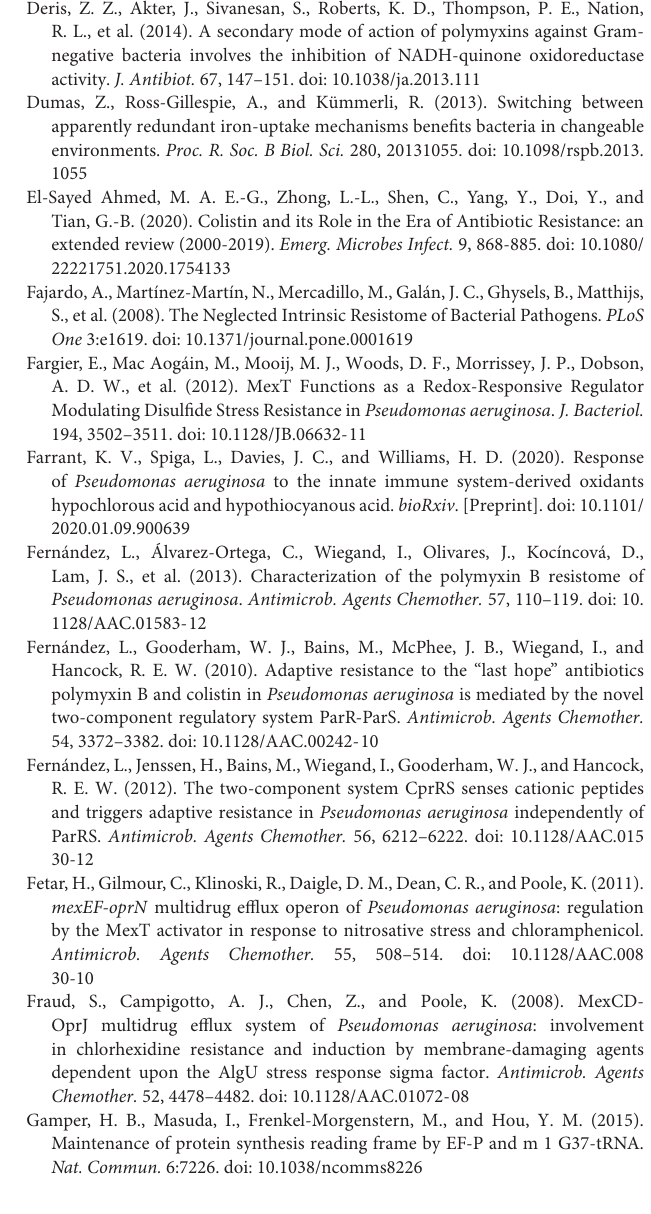
Supplementary Table 1 | RNA-seq and Ribo-seq differential gene expression analysis of Pae treated with colistin or tobramycin versus untreated control. Supplementary Table 2 | Changes in transcript and ribosomal footprint abundance of genes which contribute to polymyxin and aminoglycoside resistance/susceptibility in Pae after exposure to colistin and tobramycin. Supplementary Table 3 | Changes in transcript and ribosomal footprint abundance of genes belonging to the AlgU regulon in Pae (Schulz et al., 2015) in the presence of 8 µ g/ml